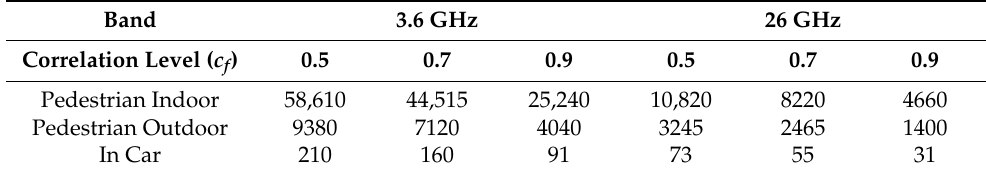
Figure 2. Coherence block (ChB) lower bound for different levels of frequency correlation in the six propagation environments considered, and for a time correlation level of 0.7. Table 2. ChB lower bound length for representative frequency correlation levels, 0.5, 0.7 and 0.9.